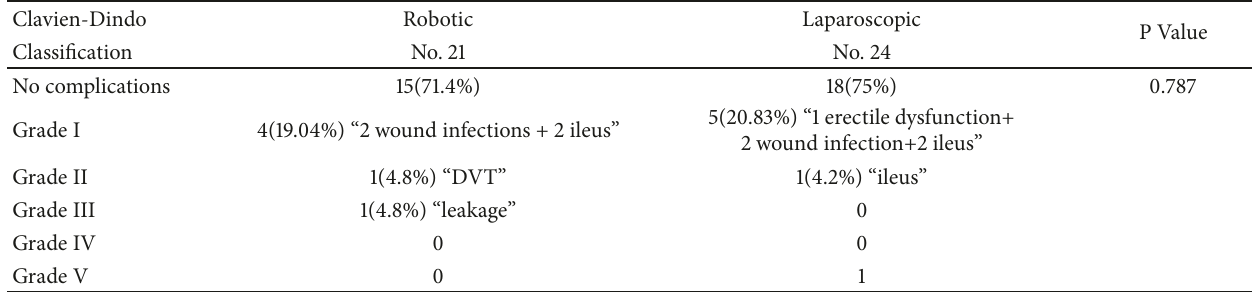
Table 4: Severity of complications according to Clavien-Dindo